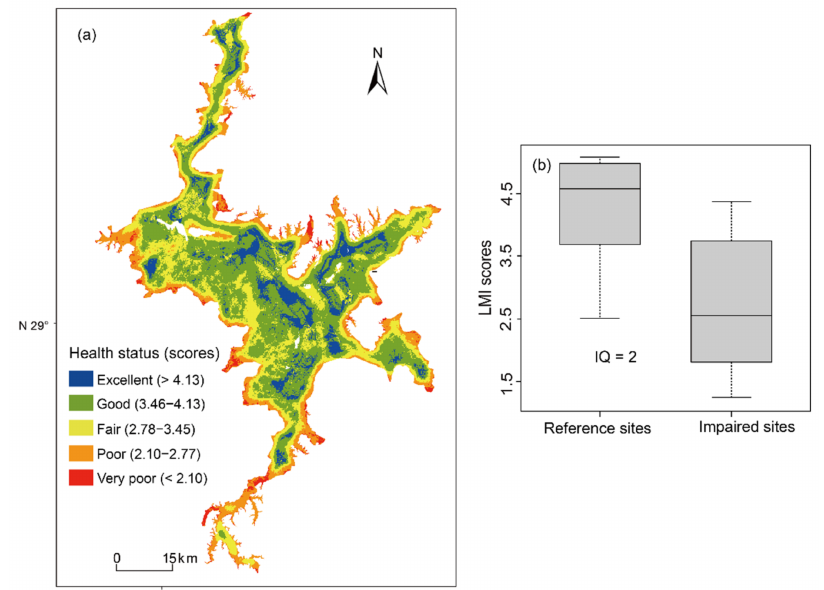
Figure 6. Conditions of the Poyang Lake wetland assessed using landscape-based multi-metric index (LMI) ( a ) and discriminatory power of the LMI scores between reference and impaired sites ( b ). IQ is the abbreviation for interquartile range score, boxes are interquartile ranges (25–75%), bars in boxes are medians, range bars indicate maximal and minimal values of